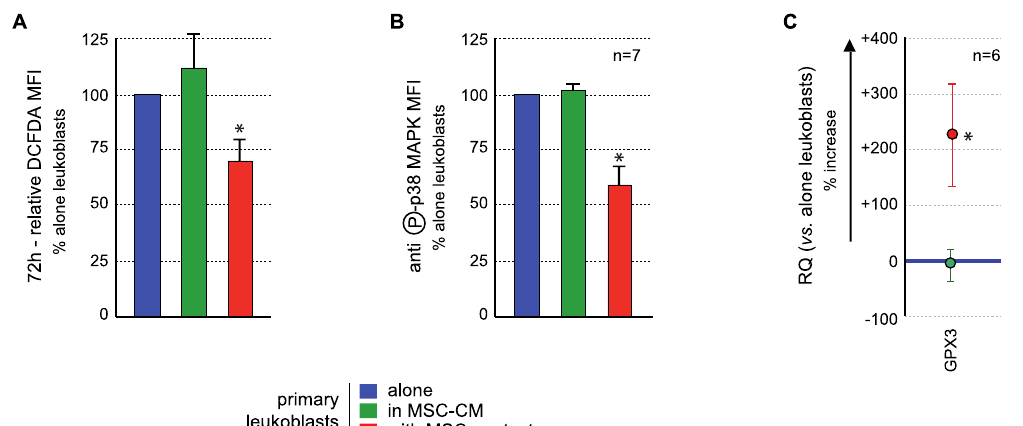
Figure 6. MSCs interact with primary AML cells to modify their ROS levels, p38MAPK activation, and GPX3 expression. Analysis was performed in primary AML cells cultured alone (blue), with MSC-CM (green) or with MSCs (red). ( A ) ROS levels were analyzed in primary AML cells by flow cytometry after CM-H 2 DCFDA labelling ( n = 13 with MSC-CM; n = 26 with MSC-contact). Primary BM-blasts from 20 AML patients were studied by coculture experiments on normal BM-MSCs from five donors (26 coculture experiments were performed due to various combinations). Seventeen AML patients (among these 20 patients) presented a decrease in ROS levels upon contact with MSCs. Blasts were used no more than three times. As expected, when AML patient blasts were studied on different MSCs, the results were not different, ruling out any MSC batch effect. Whenever possible (sufficient number of blasts), the effect of CM-MSCs was evaluated ( n = 13), and in all cases, CM-MSCs did not induce a decrease in ROS levels in AML blasts. All statistics were performed comparing different groups using the Kruskal–Wallis test comparing coculture condition ( n = 26), CM-MSCs condition ( n = 13) and control condition (blasts alone). ( B ) p38MAPK expression and activation were studied by flow cytometry after labelling with anti-p38 or anti-phospho (T180 / Y182)-p38, respectively ( n = 7); ( C ) GPX3 expression was studied by real-time PCR. Results are presented as percentage of increased or decreased relative GPX3 quantity (RQ = 2 − ∆∆ C t ) in MSC-CM or MSCs cocultured AML cells vs. AML cells cultured alone ( n = 6). * p < 0.05.